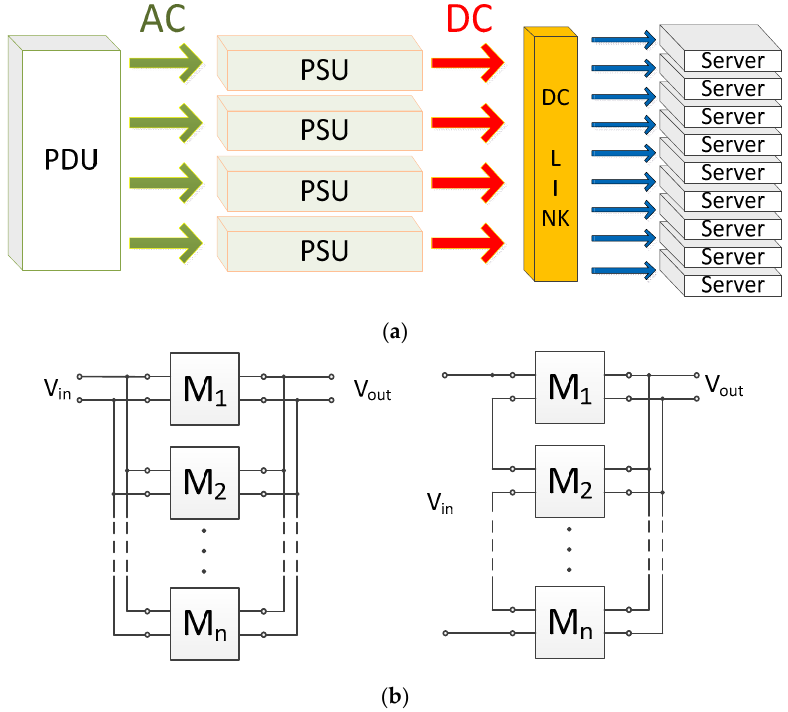
Figure 4. Modular architecture of power supply unit ( a ) and possible configurations ( b ).